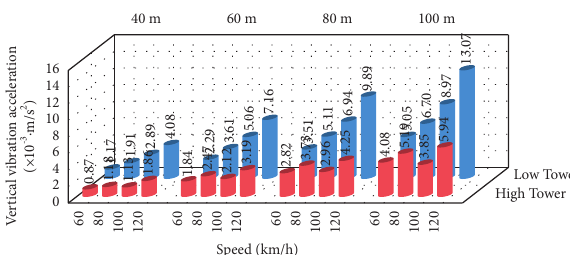
Figure 19: Comparison of vertical vibration acceleration.